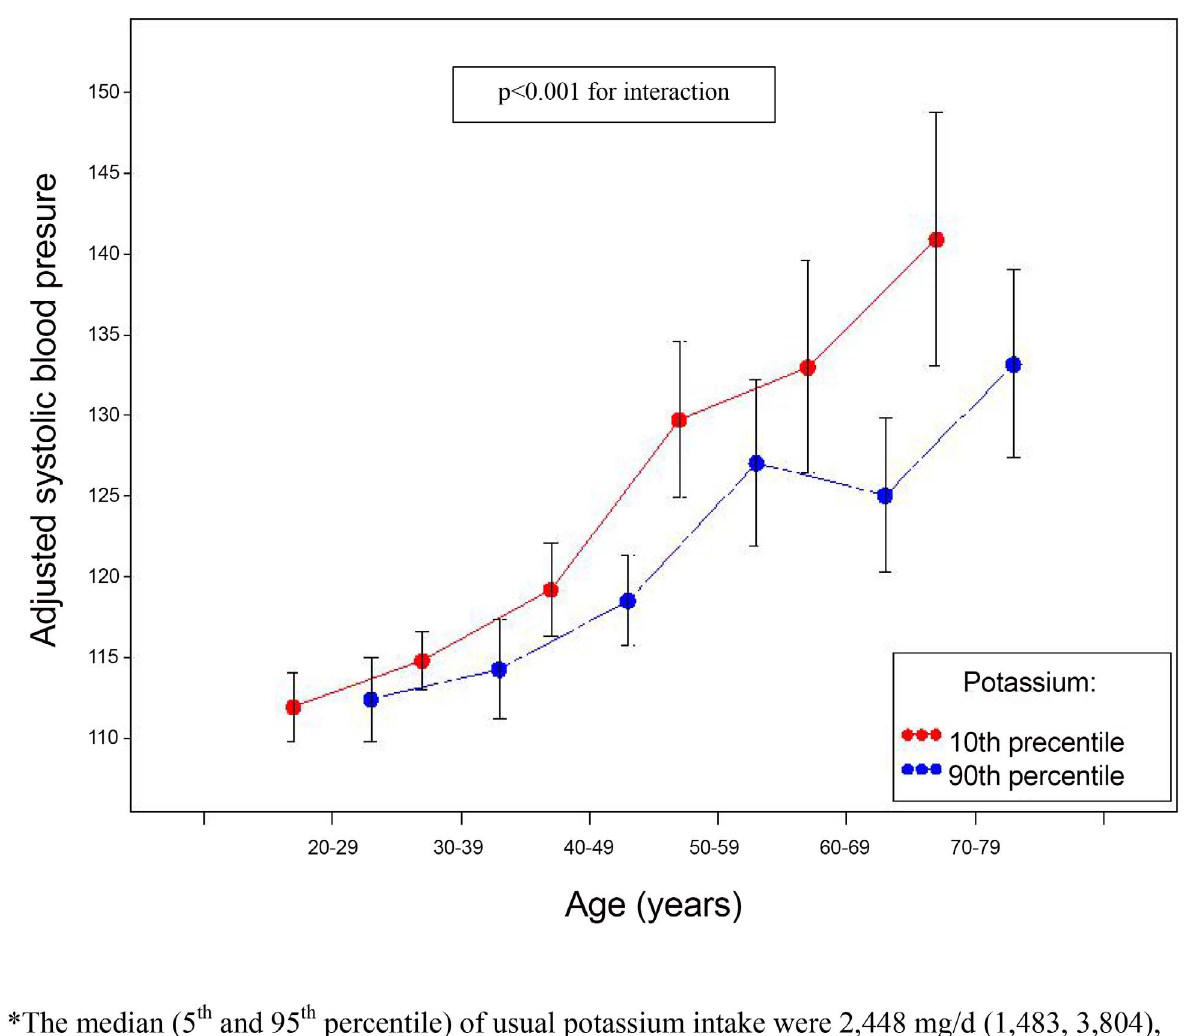
Figure 1. Adjusted systolic blood pressure (95% confidence interval) by 10 th and 90 th percentiles of potassium intake and age 20– 29, 30–39, 40–49, 50–59, 60–69 and $ 70 years among adults aged $ 20 years who were not taking antihypertensive